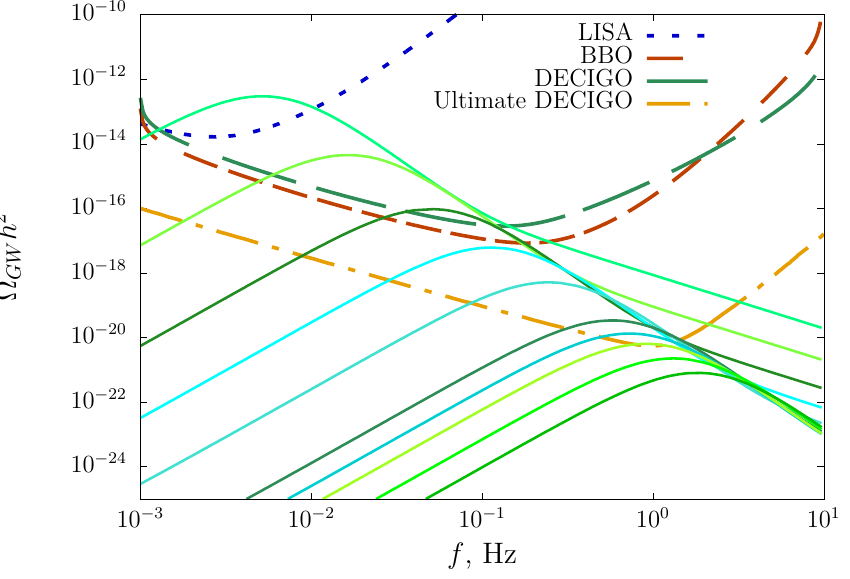
Figure 3 . Gravitational wave spectra from the first-order phase transition for points Q 1 , Q 2 , . . . , Q 10 (from top to bottom, solid lines) in model parameter space, see table 1, and sensitivity curves of LISA, BBO, DECIGO, Ultimate DECIGO experiments (dashed lines) [41, 69].